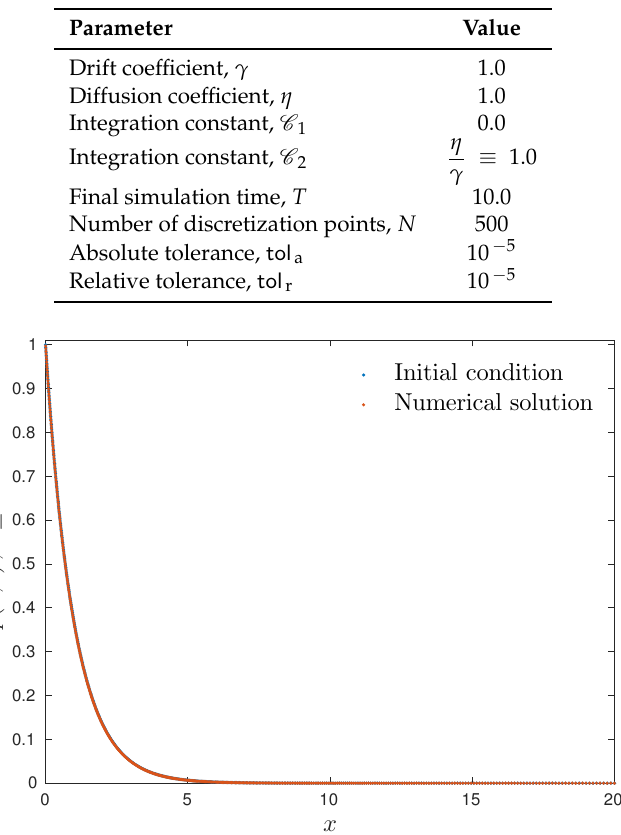
Table 1. Numerical parameters used in the steady state computations.